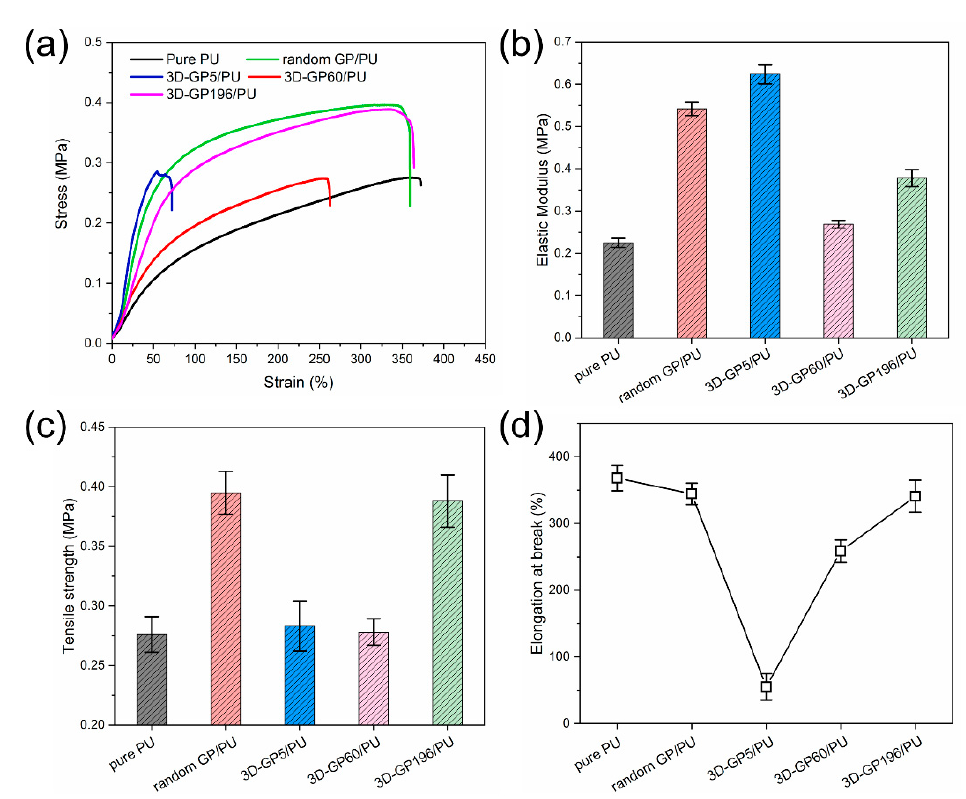
Figure 9. ( a ) Tensile stress-strain curves of the composites. ( b – d ) Elastic modulus, tensile strength, and elongation at break of the composites, respectively.